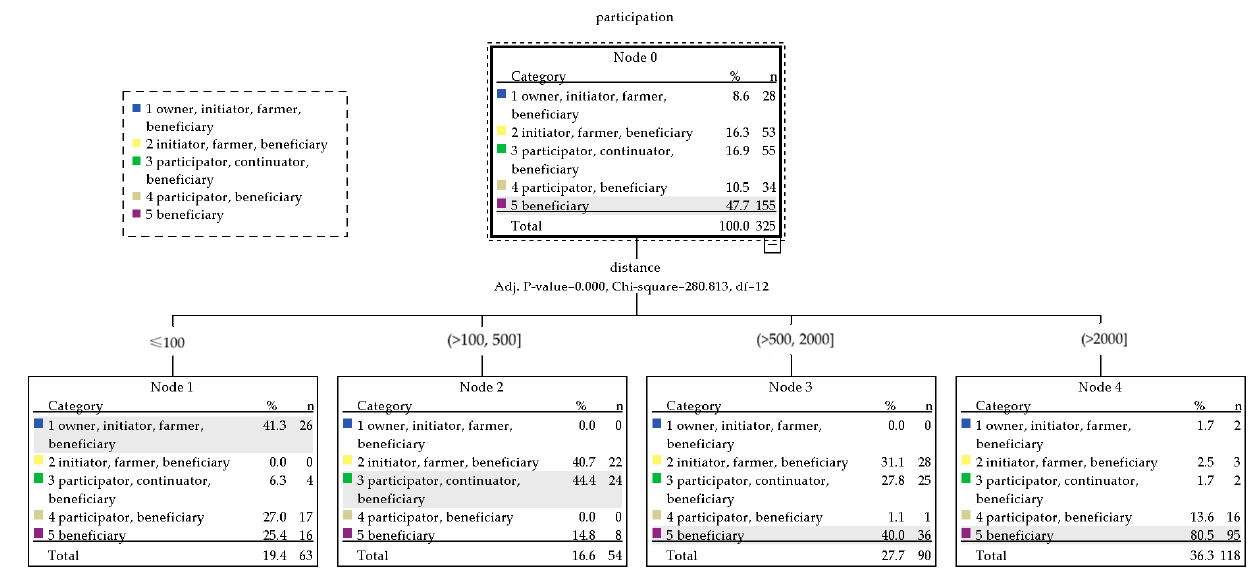
Figure 3. Decision tree analysis.